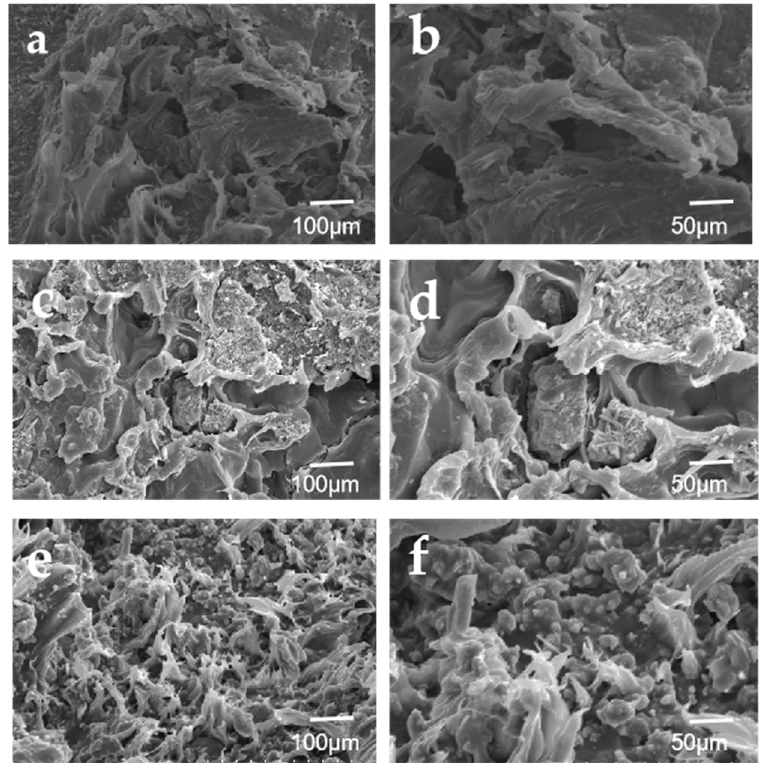
Figure 11. SEM images of bending section of flame-retardant PP composite. PP: ( a ) magnification. 500×; ( b ) magnification 1000×. 20%APP/PP: ( c ) magnification 500×; ( d ) magnification 1000×. 20% KAPP/PP: ( e ) magnification 500×; ( f ) magnification1000×.